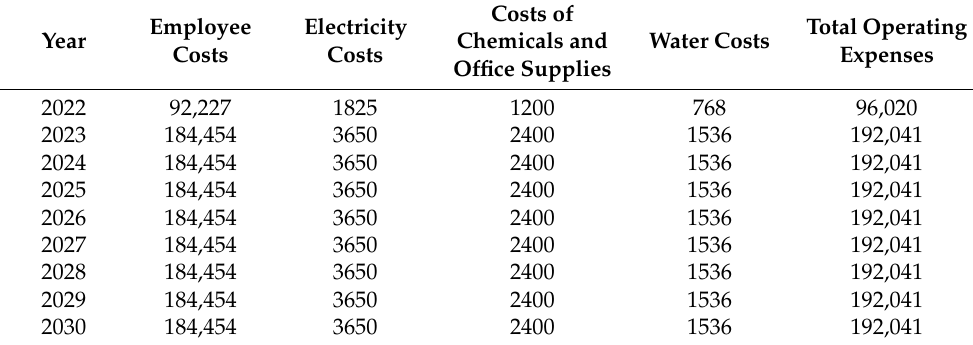
Table 4. Projection of operating expenses of the project (in EUR).